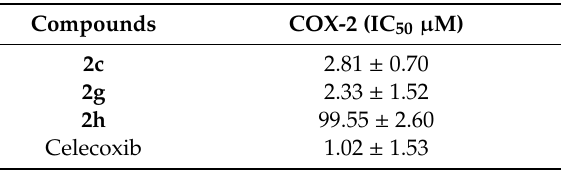
Table 2. Activity of 2c , 2g and 2h against